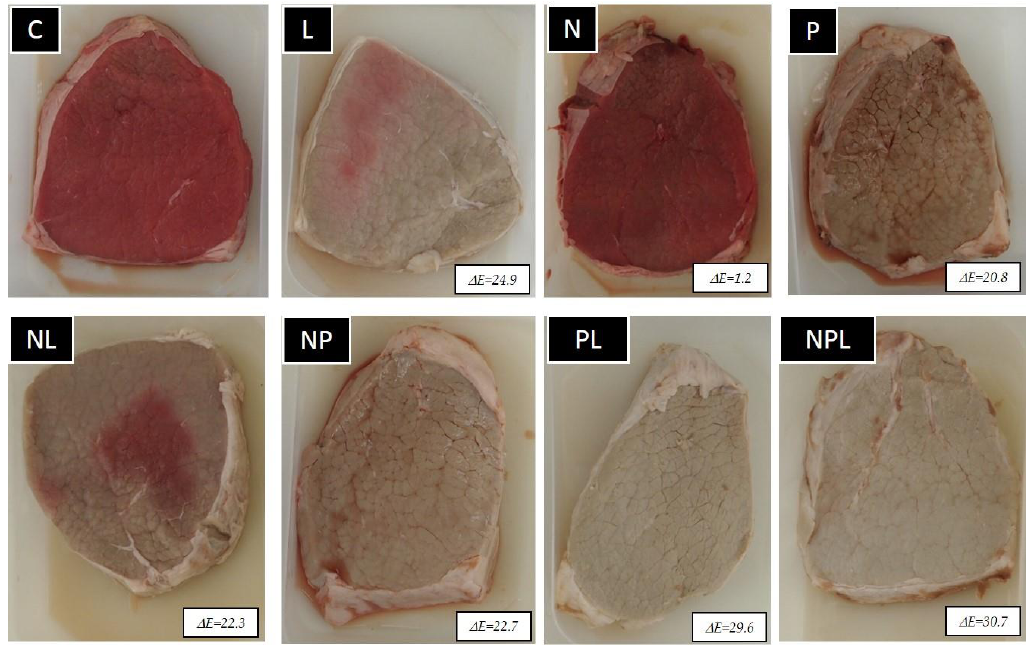
Figure 2. Steaks from the different experimental batches on day six of exposure and ΔE with respect Figure2. Steaksfromthedi ff erentexperimentalbatchesondaysixofexposureand ∆ Ewithrespecttothe to the control. C: Control (unpressurized-LPDE 0%-unmarinated); N: Unpressurized-LPDE 5%- unmarinated; M: Unpressurized-LPDE 0%-marinated; NM: Unpressurized-LPDE 5%-marinated; P: Pressurized-LPDE 0%-unmarinated; PN: Pressurized-LPDE 5%-unmarinated; PM: Pressurized-LPDE 0%-marinated; PNM: Pressurized-LPDE 5%-marinated.